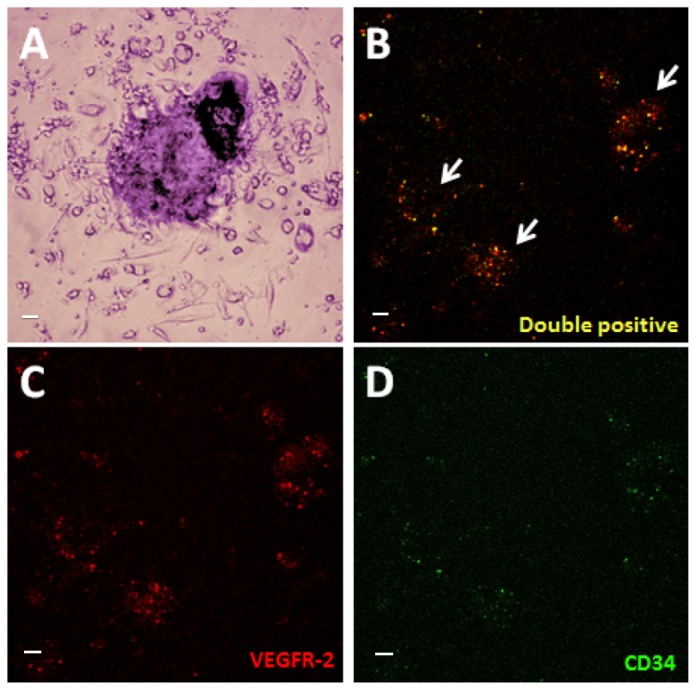
EPCs under light microscopy.(A) An EPC colony, defined morphologically as a central cluster of rounded cells surrounded by multiple spindle-shaped cells (20x magnification). (B-D) Expression of VEGFR-2 (red) and CD34 (green) was assessed under laser scanning confocal microscopy (10x magnification). Double-positive colonies (yellow) were identified as EPC colonies. Scale bar represents 20 µm.